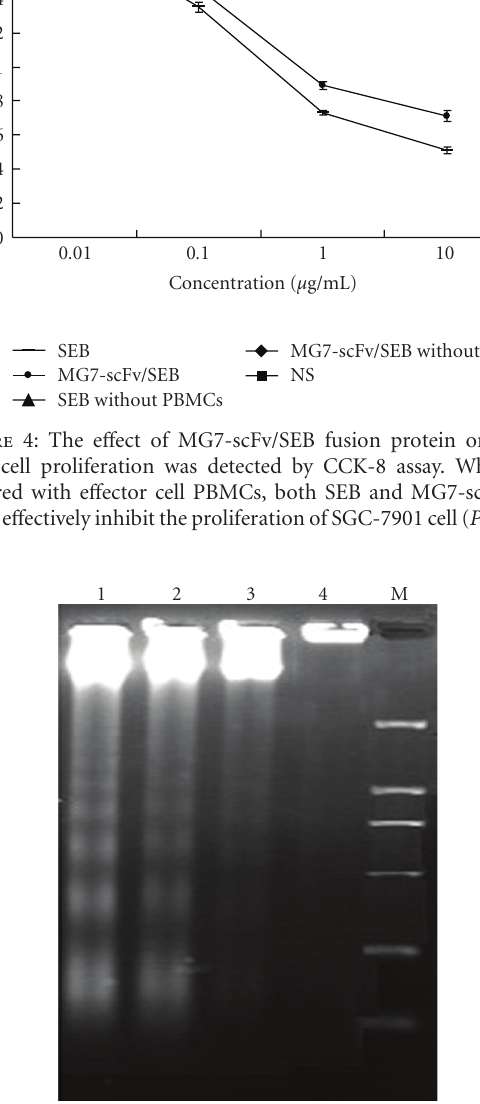
Figure 5: DNA ladder after treating with MG7-scFv/SEB. Lane 1: 10 μ g/mL MG7-scFv/SEB group; lane 2: 1.0 μ g/mL MG7-scFv/SEB group; lane 3: 0.1 μ g/mL MG7-scFv/SEB group; lane 4: normal sodium group.